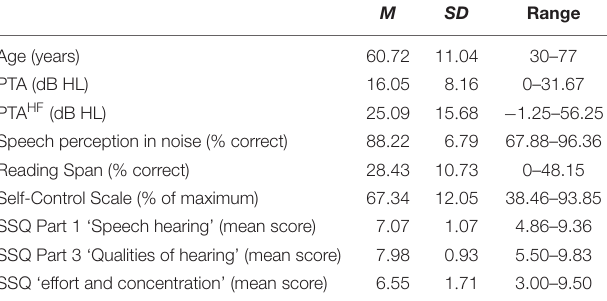
percentage of correct phonemes produced. Table 1 provides the descriptives for the perception in noise score. Higher values indicate better speech perception in